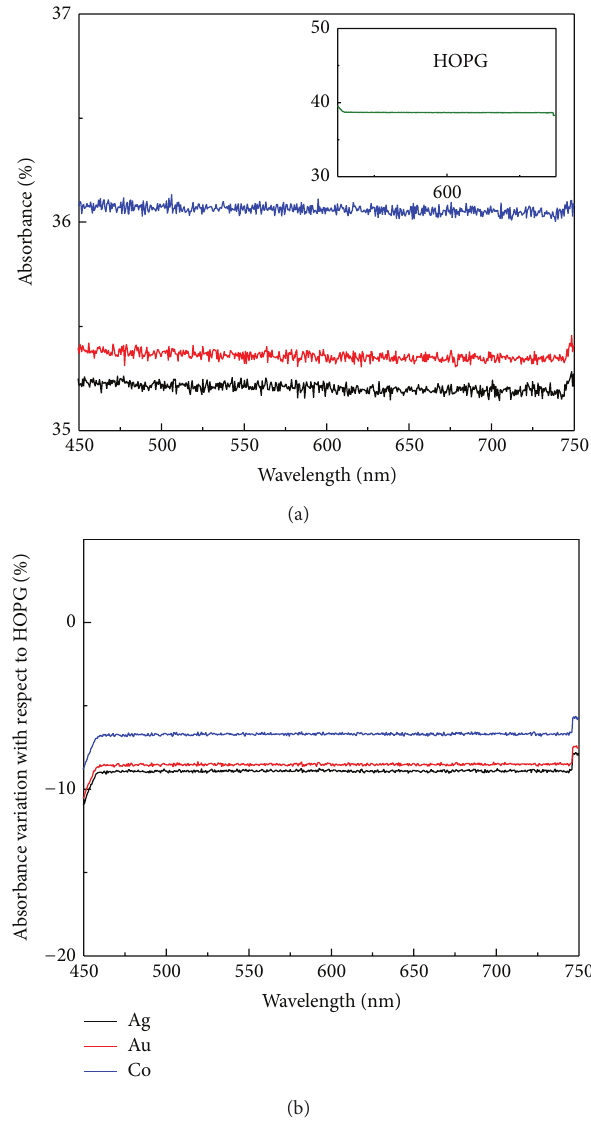
Figure 5: Optical absorption in visible region for nanoparti- cle/HOPG composites (a) and HOPG (inset in (a)). Variation of optical absorption with respect to pure HOPG